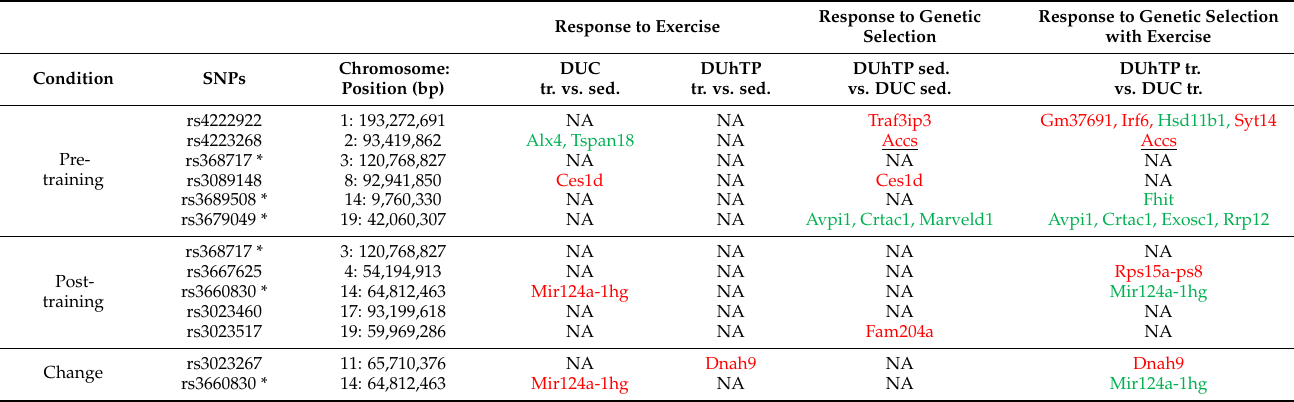
The table provides information on chromosomal localization and regulation by phenotype selection (genetic effect), training (exercise), and phenotype selection with training. Font color of the gene symbol indicates lower expression (green) and higher expression (red) with respect to the control for each comparison (unselected or untrained). Underlined genes are considered as affected only by genetic effect because of no change of expression (log 2 FC) between phenotype selection and phenotype selection with training comparison. QTL regions with significant effect are marked with an *. Abbreviation: sed. = sedentary, tr. = trained, vs. = versus, NA = not available, SNP = single nucleotide polymorphism, bp = base